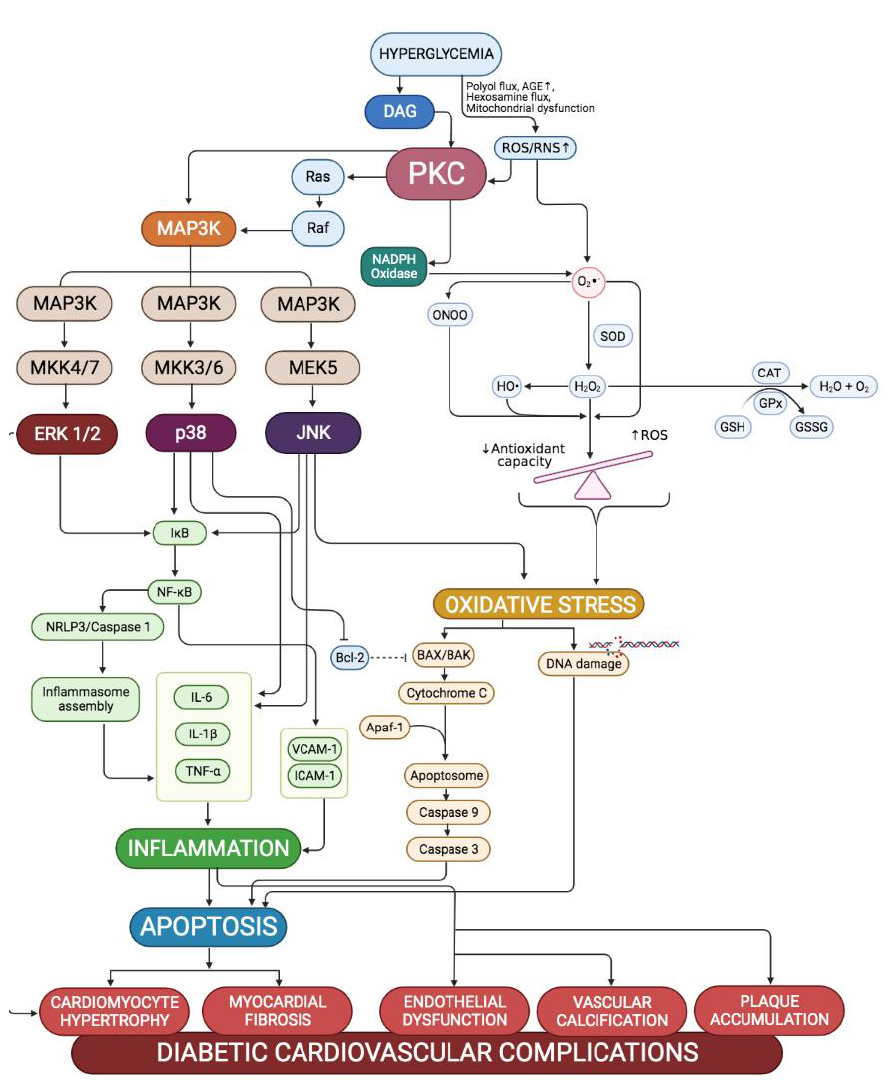
Figure 4. Proposed mechanisms involved in the pathogenesis of diabetic cardiovascular complications via the PKC-MAPK pathway. Persistent hyperglycemia induces de novo production of diacylglycerol (DAG), which along with reactive oxygen (ROS), would induce the activation of PKC. Hyperglycemia also generates ROS and nitrogen species (RNS) in excess via NADPH oxidase, generating oxidative stress in the cardiac and vascular tissues. By activating Raf dependently and independently of Ras activation, PKC phosphorylates MAP3Ks of the MAPK subfamilies cascades. Following a stimulation, activation of MAPK requires a three-tiered kinase cascade; in which a MAPK kinase kinase (MAPKKK, MEKK, MAP3K or MKKK) activates a MAPK kinase (MAPKK, MEK, MAP2K or MKK), which in turn activates the targeted MAPKs (ERK1/2, JNK and p38) through serial phosphorylation. Uncontrolled activation of MAPKs induces inflammation and cell apoptosis, leading to pathologic cardiac remodelling and vascular dysfunction. Arrows represent the subsequent event/product in the pathway; tappered line represents inhibition action; dotted tappered line represents halted inhibition action.